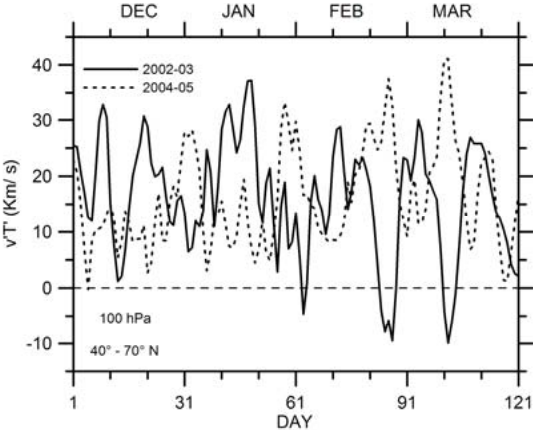
Fig. 5. Zonal mean meridional heat flux v 0 T 0 (Kms − 1 ) at 100hPa